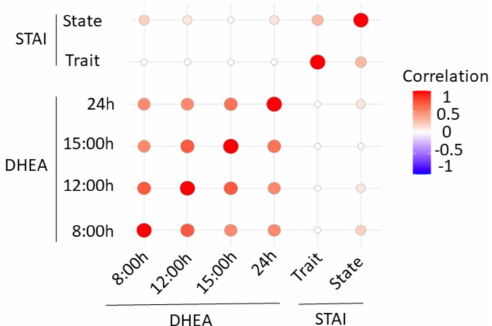
Figure 3. Correlation chart of DHEA levels determined at 8 h (301.9 ± 44.6 pg/mL), 12 h (250.9 ± 35.3 pg/mL), 15 h (235.7 ± 33.6 pg/mL), 24 h (221.4 ± 30.3 pg/mL) [38] and STAI scores. Table 4. COS scores regarding gender, professional status (nurses and medical doctors) and hospitals.